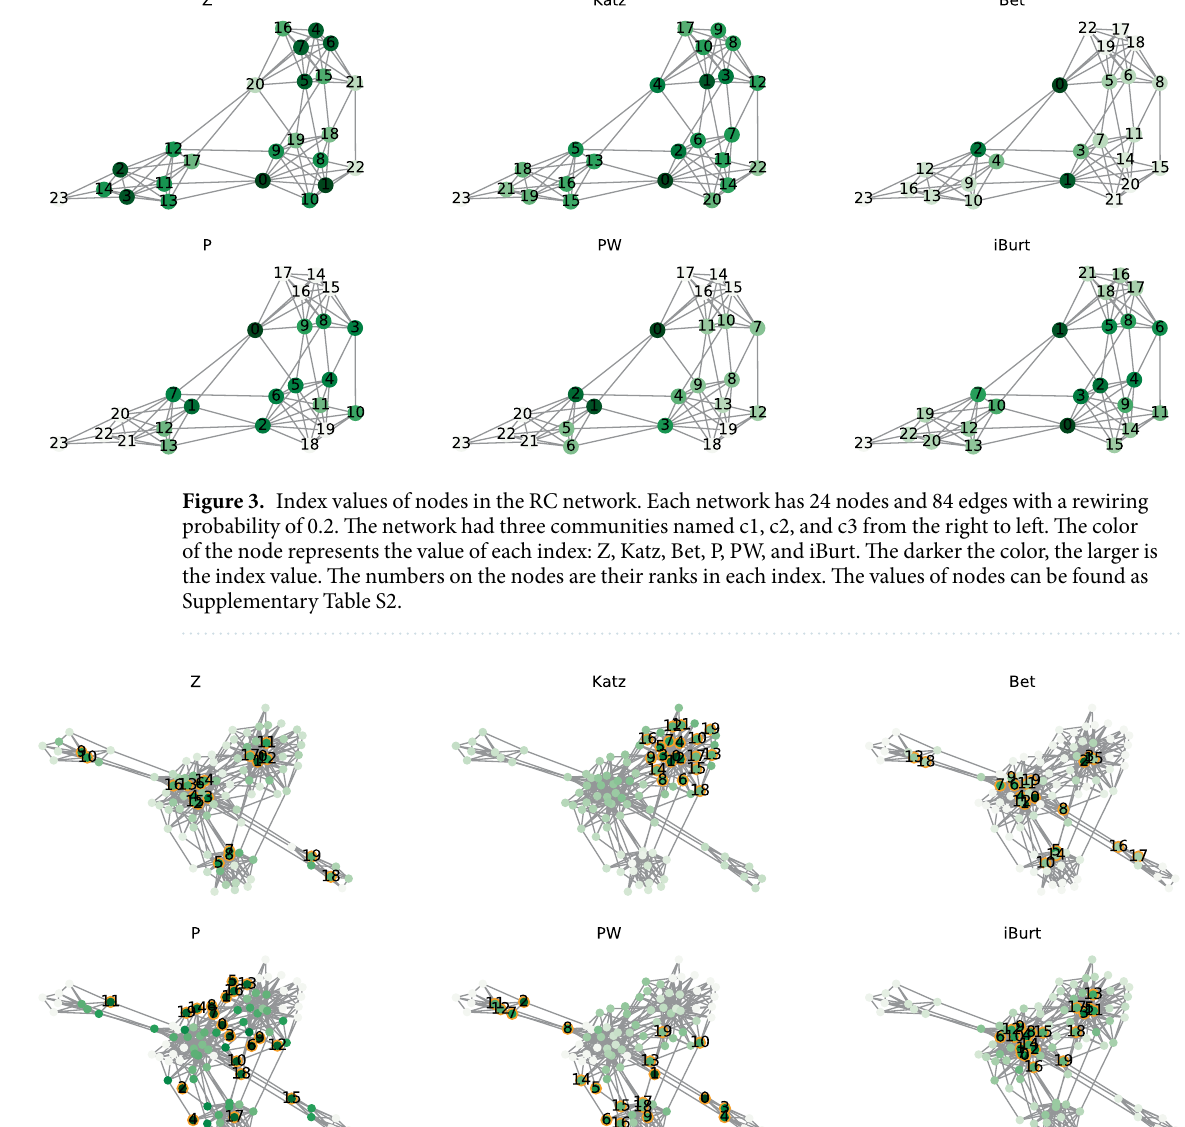
those mediating distant communities’ relationships. In short, only PW could detect nodes connecting distant communities in this network. (Fig. 4). Tohoku network: diverse link density with high community relevance. The limit of the P appeared markedly in the Tohoku network with diverse degrees holding five communities, and we found that PW was the best at identify- ing the nodes connecting communities with low relevance. In this network, one community had relatively few inter-community links, while the others were strongly connected to each other (Table 3). Z, Katz, P, and iBurt highly ranked the nodes within these highly relevant communities and did not identify structural holes. On the other hand, both Bets and PW highly ranked the nodes between weakly connected communities, but PW showed better performance in identifying them (Fig. 5).